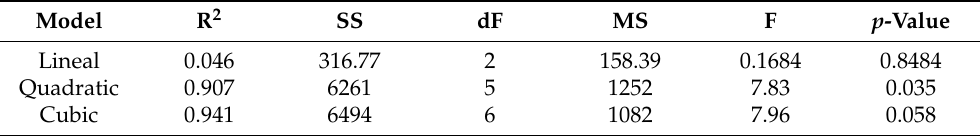
Table 5. F-test for choosing the efficiency model ( TOC ).